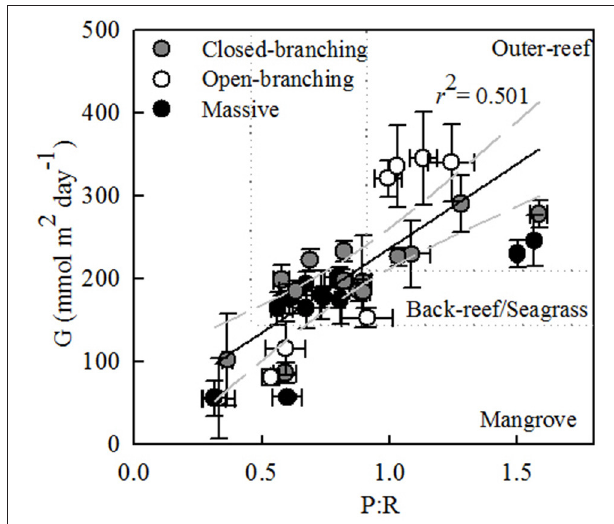
FIGURE 5 | Mean daily integrated net calcification for each coral species (G) (mmol m 2 day − 1 ) vs. the ratio of gross photosynthesis (P) to respiration (R). Regression is shown with 95% confidence interval (gray dashed line). The dotted lines denote the different